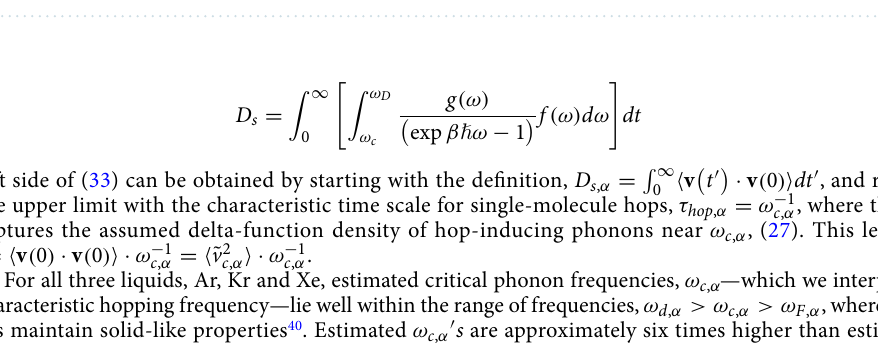
Figure 4. Temperature-dependent self-diffusion coefficient of liquid krypton. See the caption to Fig. 3 for a description of the phonon model of self-diffusion. The experimental self-diffusion data was reported in 38 ; experimental uncertainty was estimated to be less than 5 % 38,61